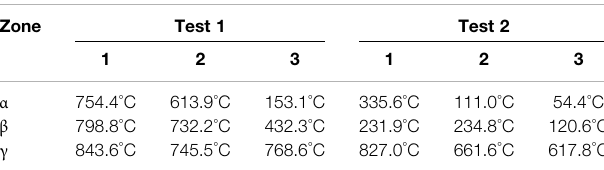
TABLE 2 | Maximum temperatures of fi re